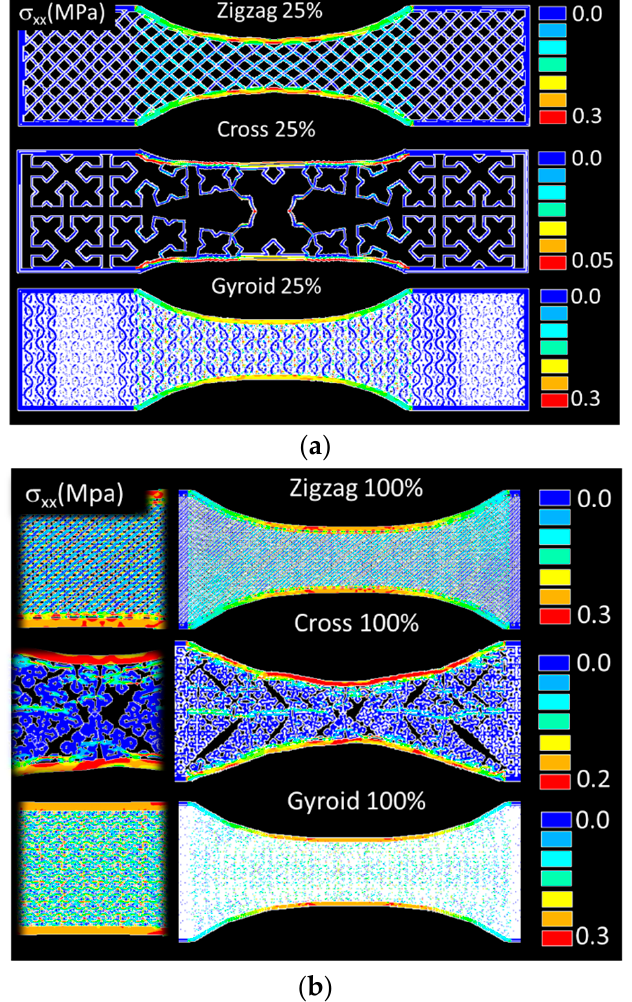
Figure 6. Predicted stress component σ xx field for the three studied filling patterns. Infill ratio ( a ) 25%, ( b ) 100%.